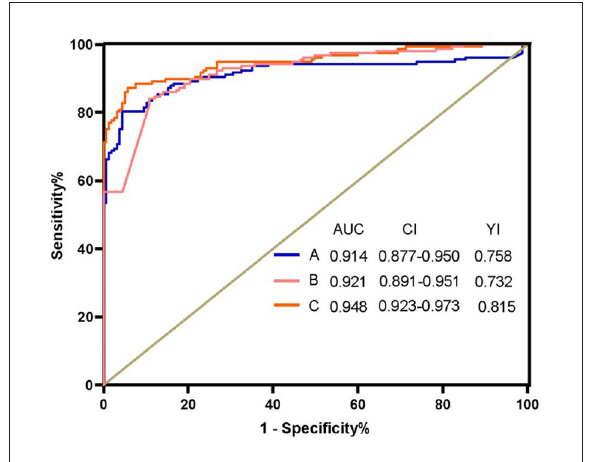
FIGURE6 Receiver operating characteristic curve analysis (ROC) of Deoxycholic acid, Palmitic amide and their combination. (A) ROC of Deoxycholic acid (B) ROC of Palmitic amide. (C) ROC of the combination Deoxycholic acid, Palmitic amide. AUC, area under the curve; CI, confidence interval; YI, Youden